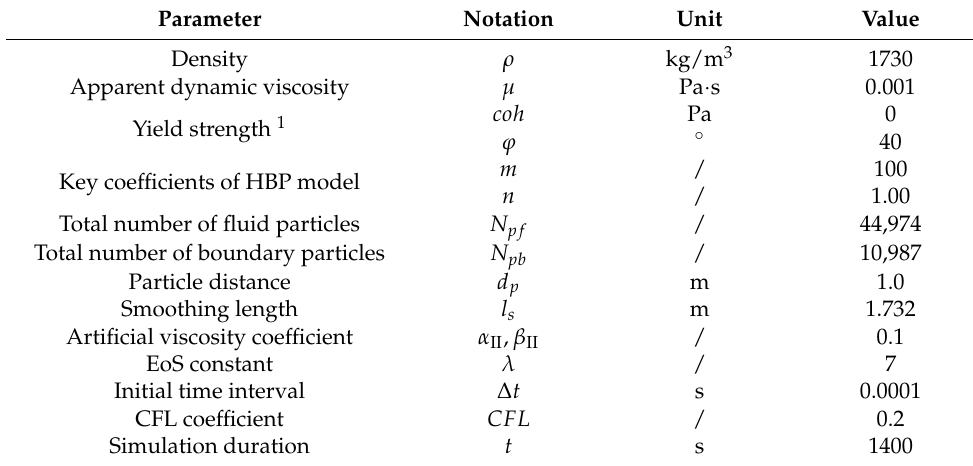
Table 1. Influencing parameters and their values in the landslide